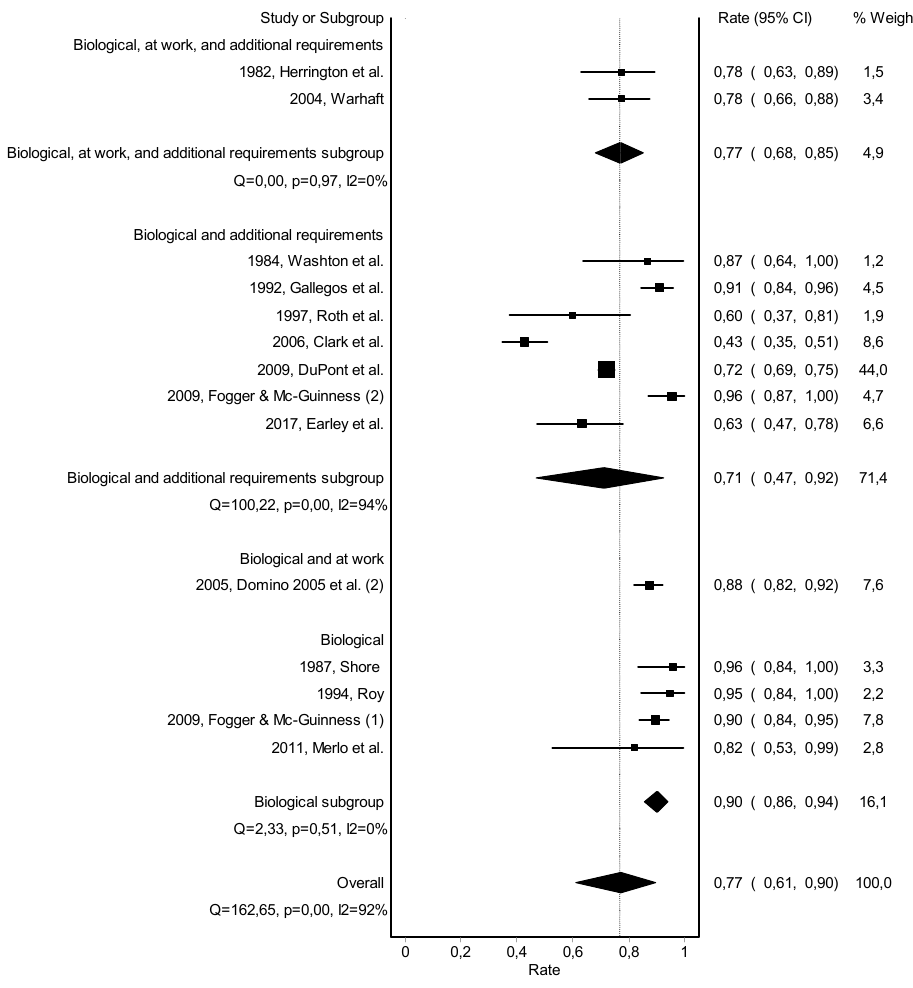
Figure A7. Forest plot of the pooled work retention rate—subgroup analysis based on type of monitoring.